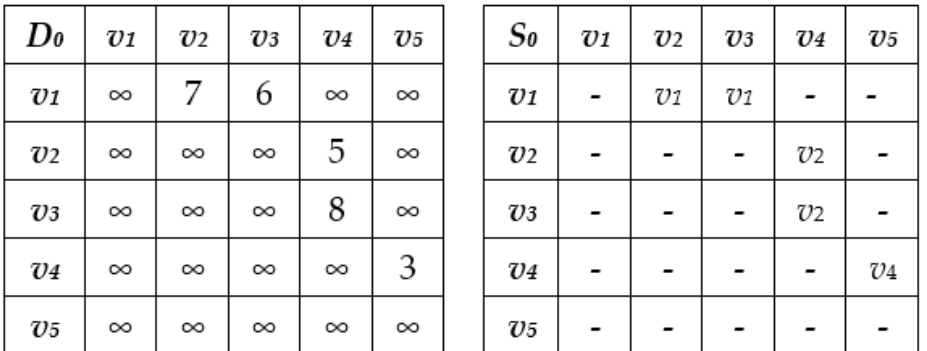
Figure 5. Matrices D 0 and S 0 at the first iteration of the algorithm.